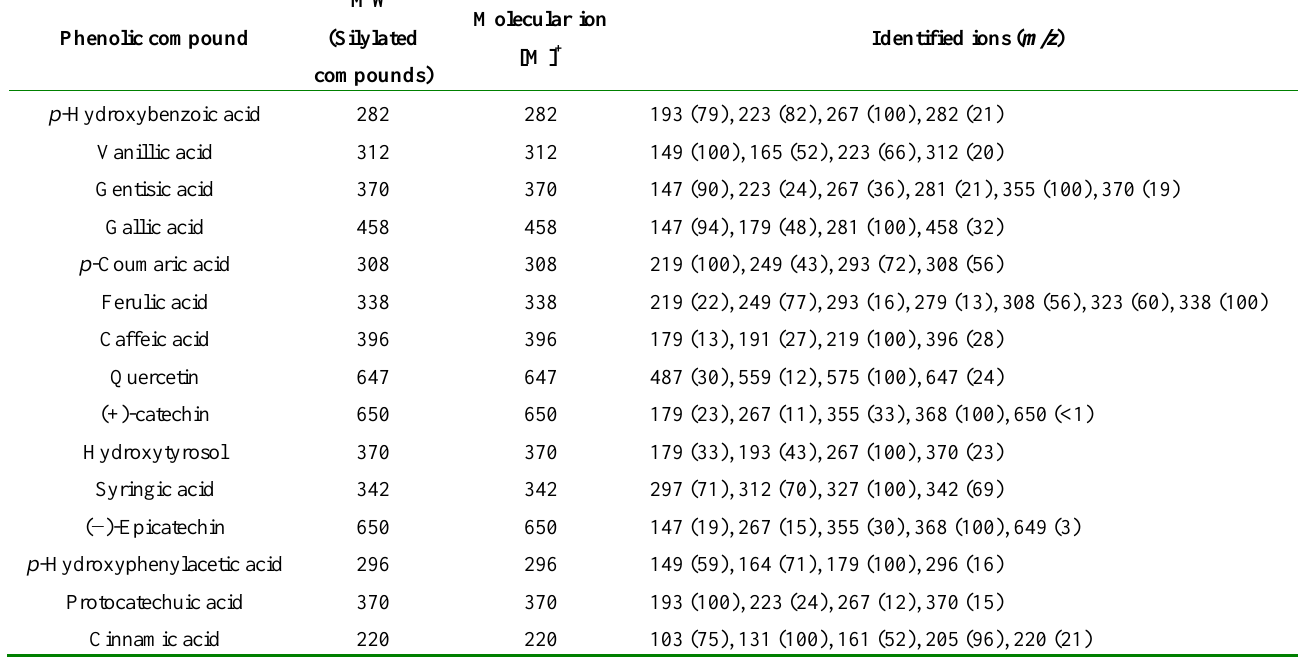
Table 2. Molecular weights (MW) and important ions present in the mass spectra of silylated phenolic compounds a in the examined plant extracts by